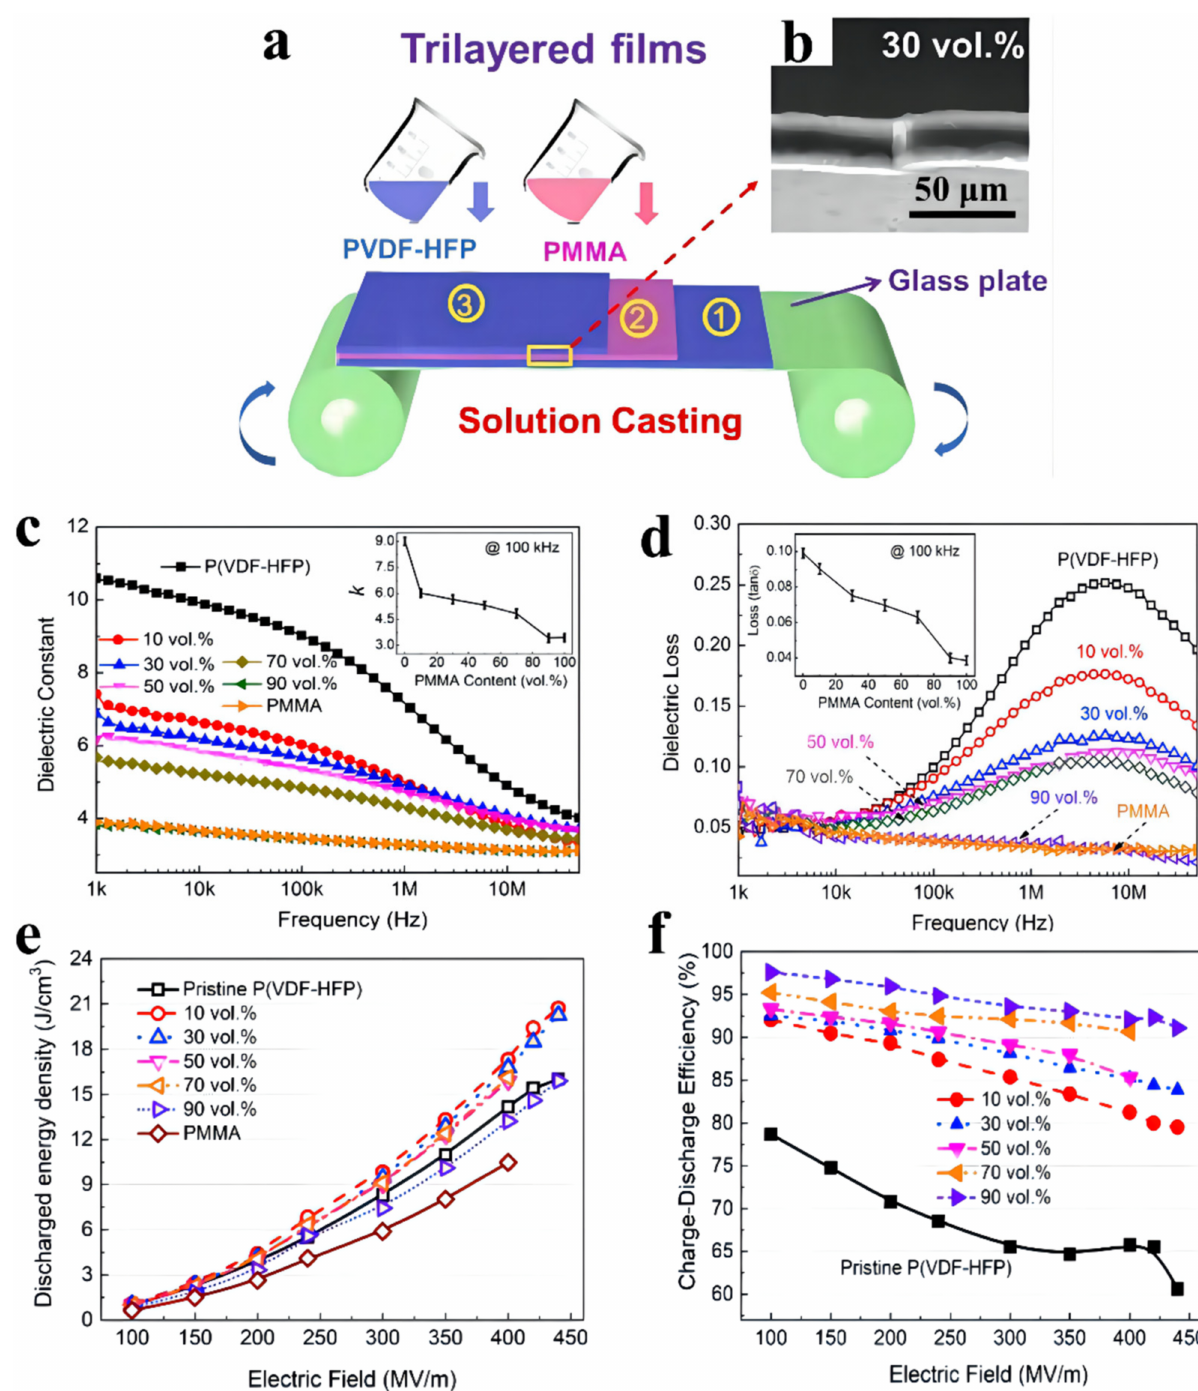
Figure 5. ( a ) Schematic illustration of the tri-layered all-polymer films and ( b ) SEM image of the cross- section of the tri-layered all-polymer film with 30 vol.% PMMA. Frequency-dependent ( c ) dielectric constant and ( d ) dielectric loss of the tri-layered all-polymer films with different PMMA volume fractions. ( e ) Charge–discharge efficiency. ( f ) Discharged energy density. Adapted with permission from [35], Copyright © 2022